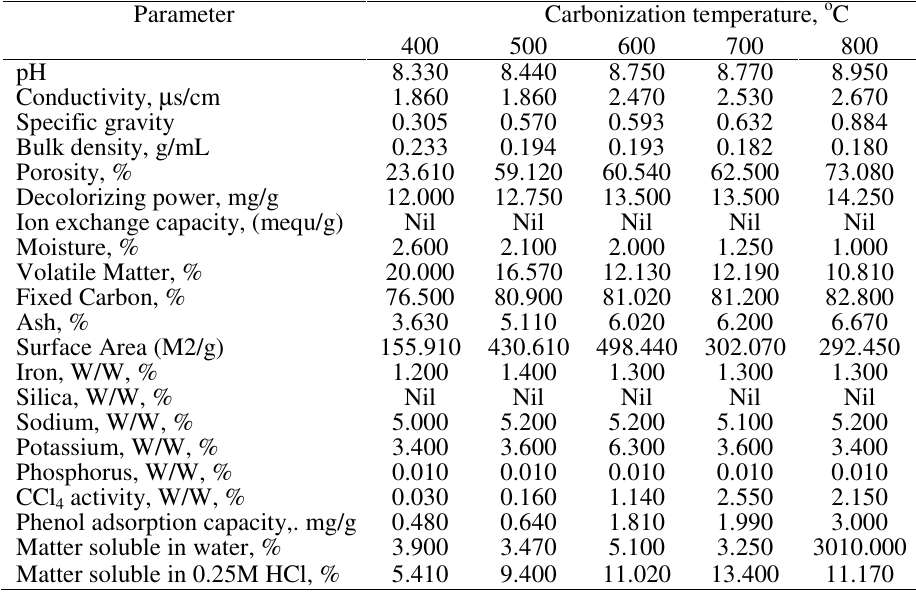
Table 2. Characteristics of Parthenium activated carbon prepared by physical activation